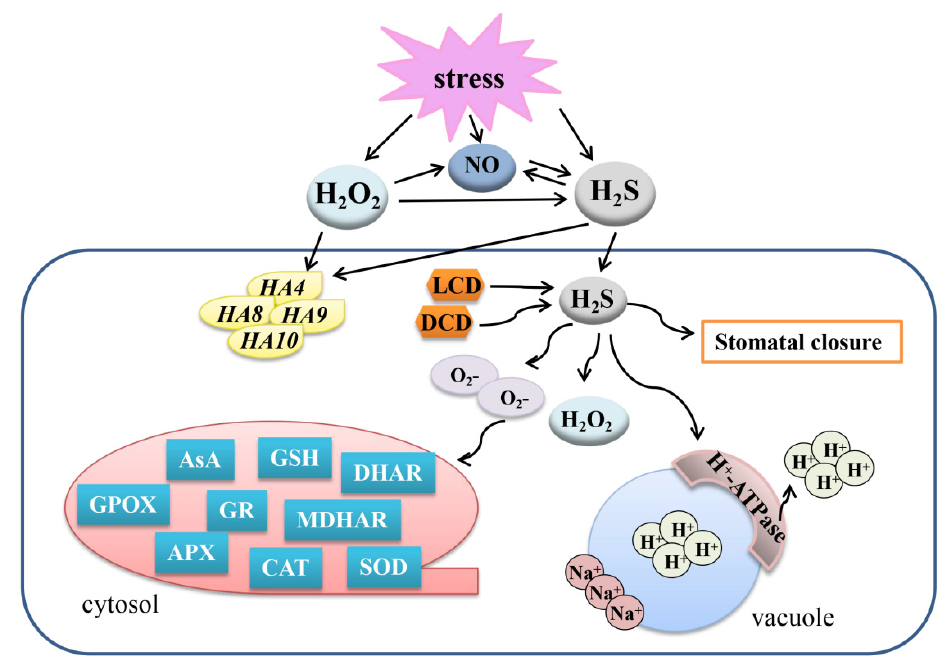
Figure 4. Overview of the mechanisms of the crosstalk between H 2 S, NO, and H 2 O 2 to regulate plant response to abiotic stresses. H 2 S, hydrogen sulfide; H 2 O 2 , hydrogen peroxide; NO, nitric oxide; LCD, L ‐ cysteine desulfhydrase; DCD, D ‐ cysteine desulfhydrase; AsA, ascorbic acid; GSH, glutathione; GR, glutathione reductase; APX, ascorbate peroxidase; GPOX, guaiacol peroxidase; CAT, catalase; SOD, superoxide dismutase; DHAR, dehydroascorbate reductase; MDHAR, monodehydroascorbate reductase.